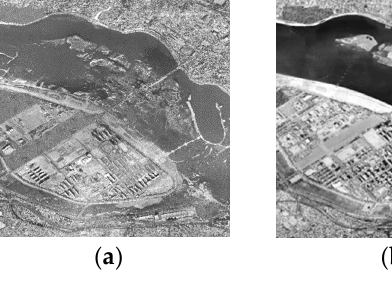
Figure 1. Example of yearly aerial image management: aerial images of the same region as layers based on the year the image was taken: ( a ) 1978; ( b ) 1989; ( c ) 1996; ( d ) 2020. All images are layer data, based on the year the image was taken, at the tile position of {level: 10, IDX: 8730, IDY:3627}.